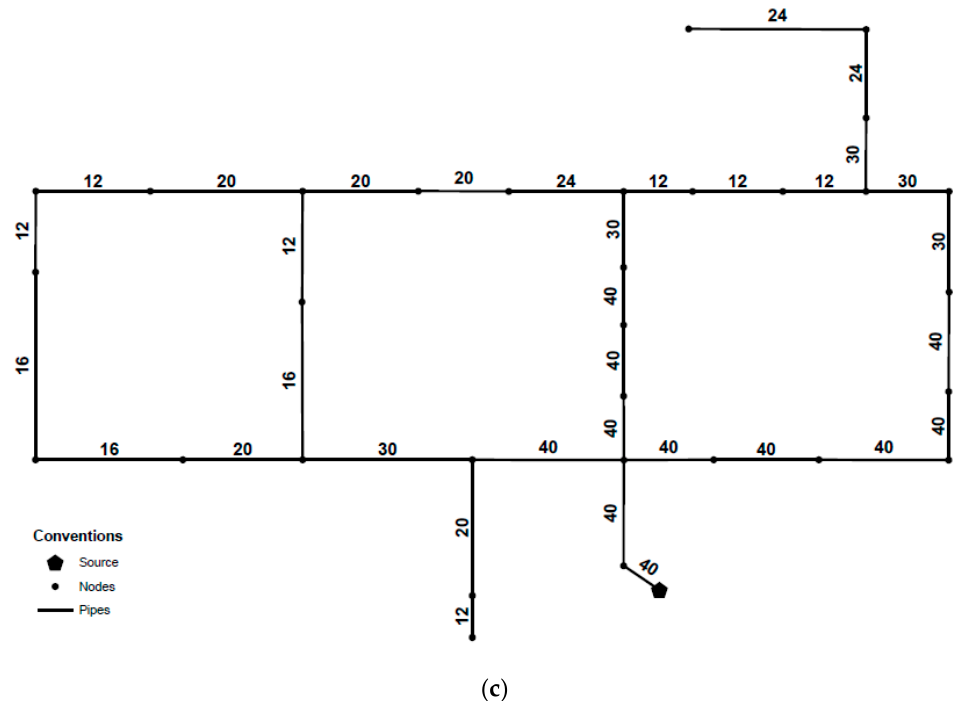
Figure 8. ( a ) General layout and Spanning Tree for Hanoi Network. Dashed lines are pipes from the original networks that are not included in the Spanning Tree ( b ) OPUS design considering continuous diameters (in inches) ( c ) OPUS design considering discrete diameters (in inches).